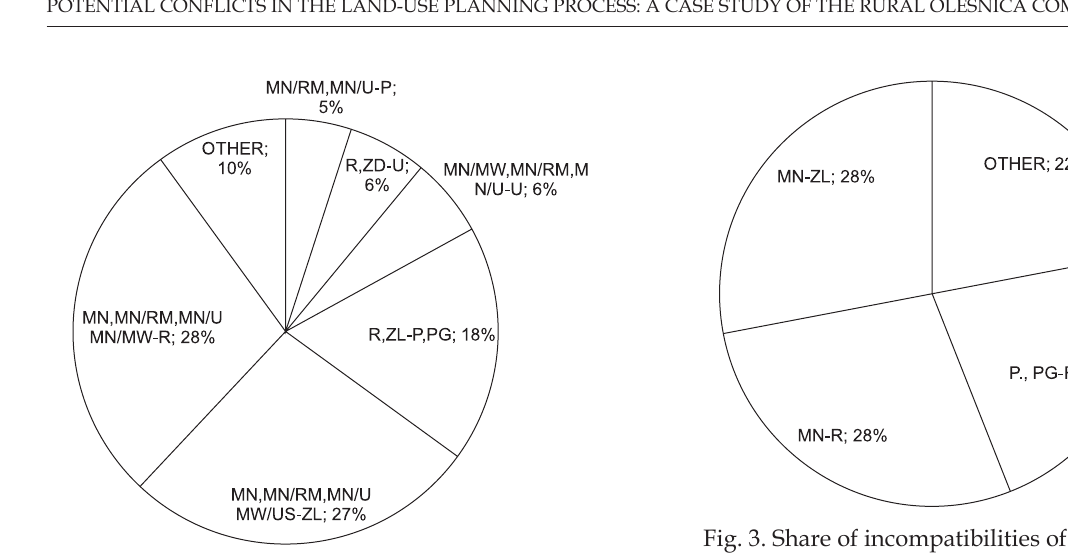
Fig. 2. Share of incompatibilities of land use allocations occurring on the border of the commune. Oleśnica – 2016. Source: own study.